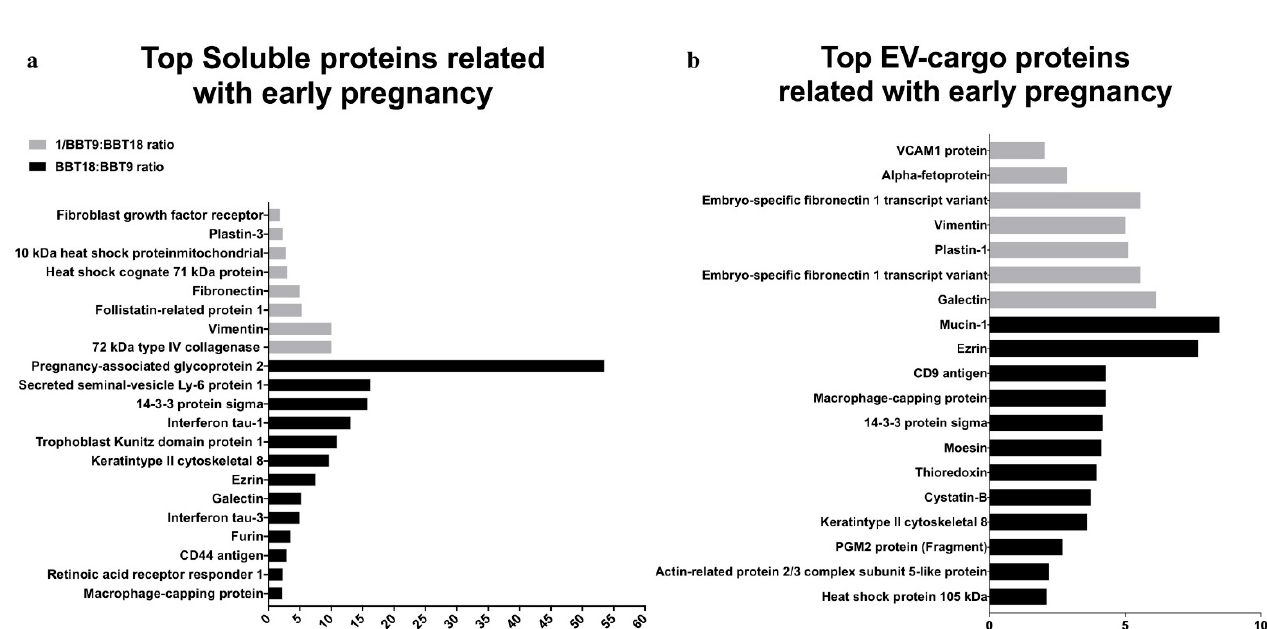
Figure 3. Bovine blastocyst embryonic trophectoderm primary cultures release soluble proteins ( a ) and EV-cargo proteins ( b ) associated with early pregnancy.